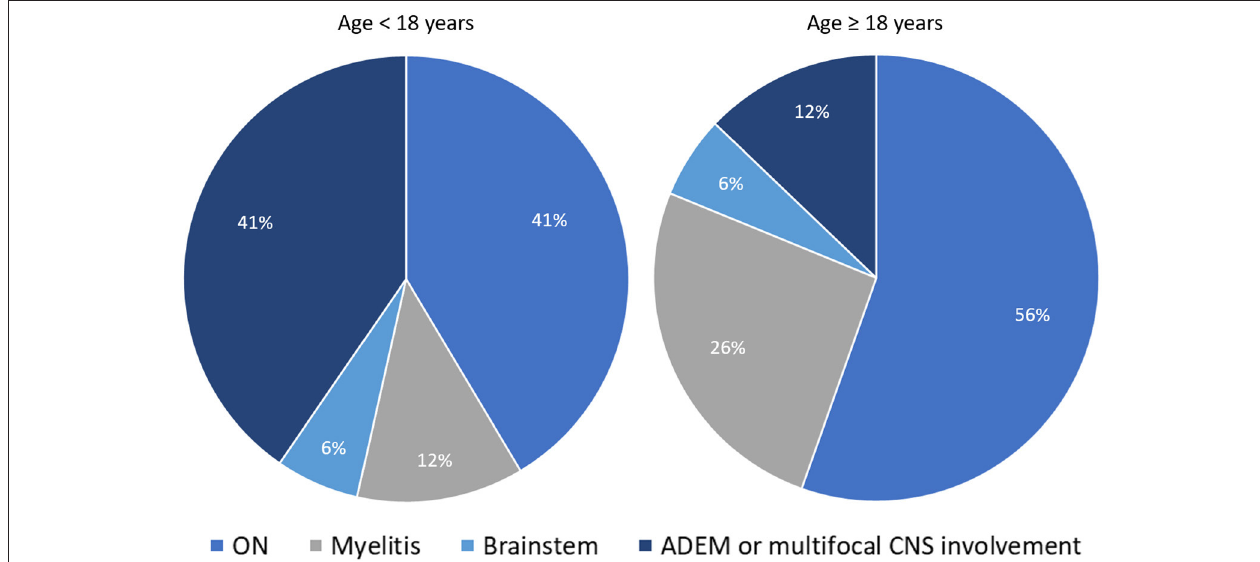
FIGURE 1 | Distribution of different disease phenotypes at MOGAD presentation stratified by age. The two pie-charts show the relative frequency of different disease phenotypes at MOGAD onset in patients below 18 years of age and older: ON (optic neuritis, unilateral or bilateral); myelitis; brainstem syndromes; ADEM (acute disseminated encephalomyelitis), or multifocal central nervous system involvement without encephalopathy. Note that the frequency of ADEM is significantly higher in younger patients. The reported frequencies are abstracted from Cobo-Calvo et al.